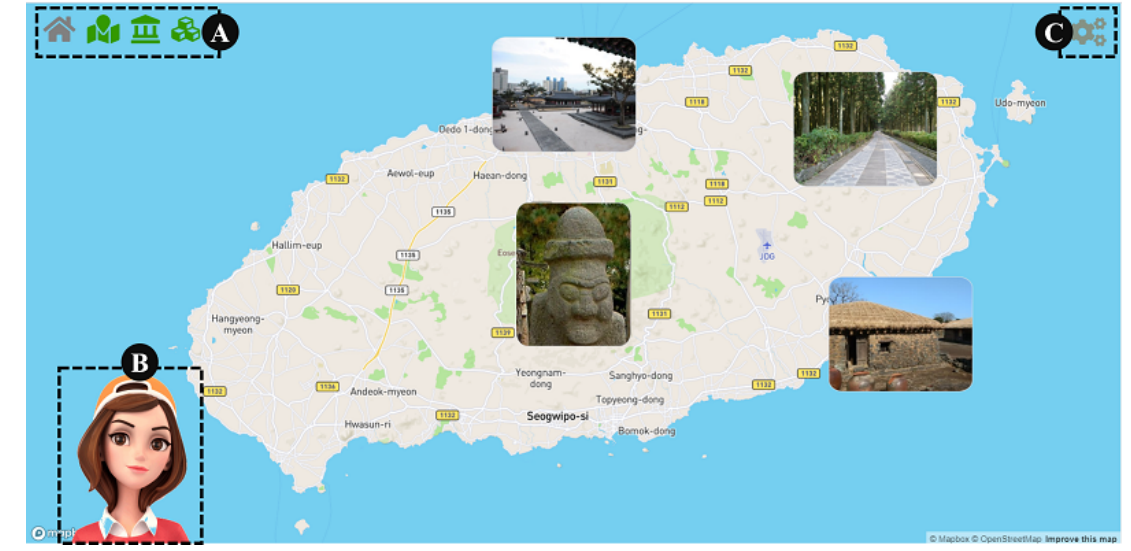
Figure 1. The virtual reality (VR) component—( A ) utility section where users can toggle information on or off, ( B ) virtual assistant to support users, ( C ) configuration section to update heritage information. Figure 1 introduces visitors to four destinations: (1) Dol Harubang—Jeju’s stone guardian deity and cultural symbol; (2) Gwandeokjeong Pavilion—a training ground built during King Sejong’s reign (1448) as a model of excellence in strengthening the minds and souls of soldiers; (3) Bijarim Forest—nicknamed the “Forest of a Thousand Years”, a haven for hundreds of bija (nutmeg yew) trees and the largest forest in the world to be made up of one plant species, also sheltering a 800-year-old, conjoined nutmeg yew; and (4) Jeju Folk Village—the highlight of the island’s heritage, featuring a mountain village, a fishing village, a botanical garden, a market place, an old government